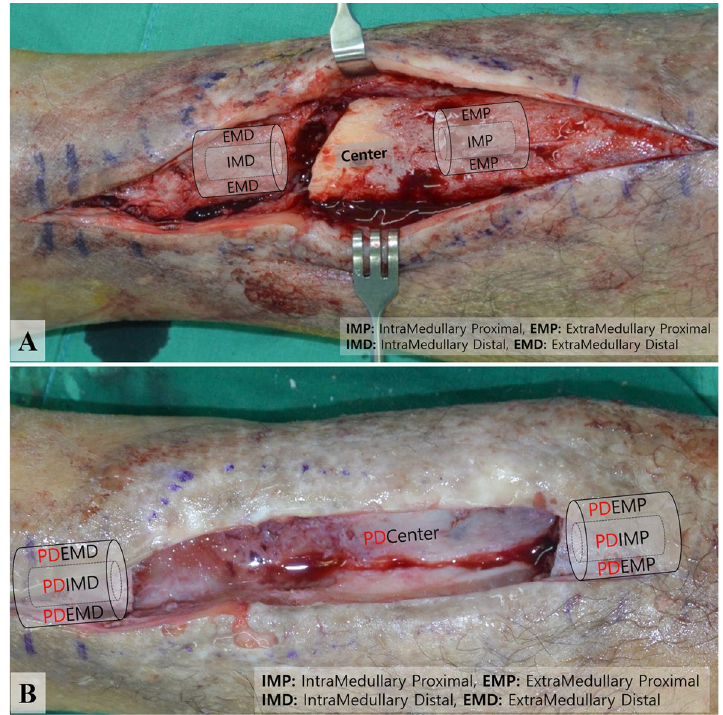
Figure 3. Intraoperative site-specific culture, including both index ( A ) and PD cultures ( B